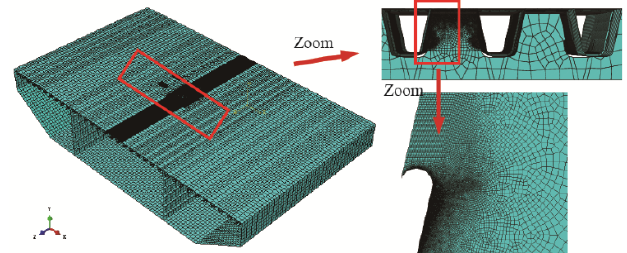
Figure 4. Finite Element Model of Steel Box Girder.